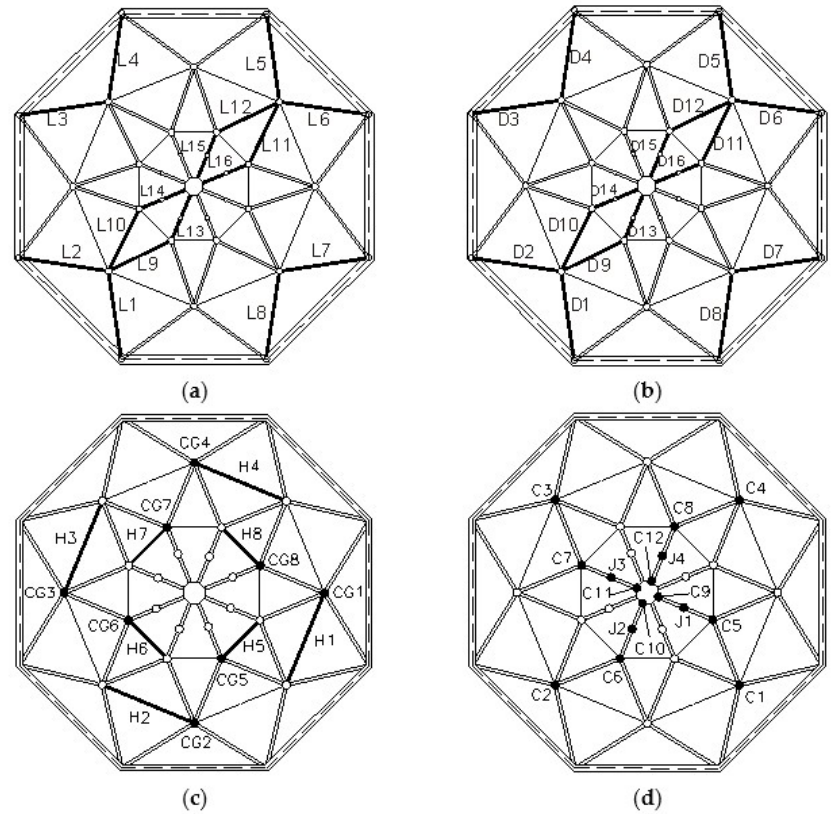
Figure 12. Layout of the measuring points of the specimen. ( a ) Strain points for the hinged beams; ( b ) Axial force points for the OCs; ( c ) Axial force points for the ring cables; ( d ) Displacement points for the